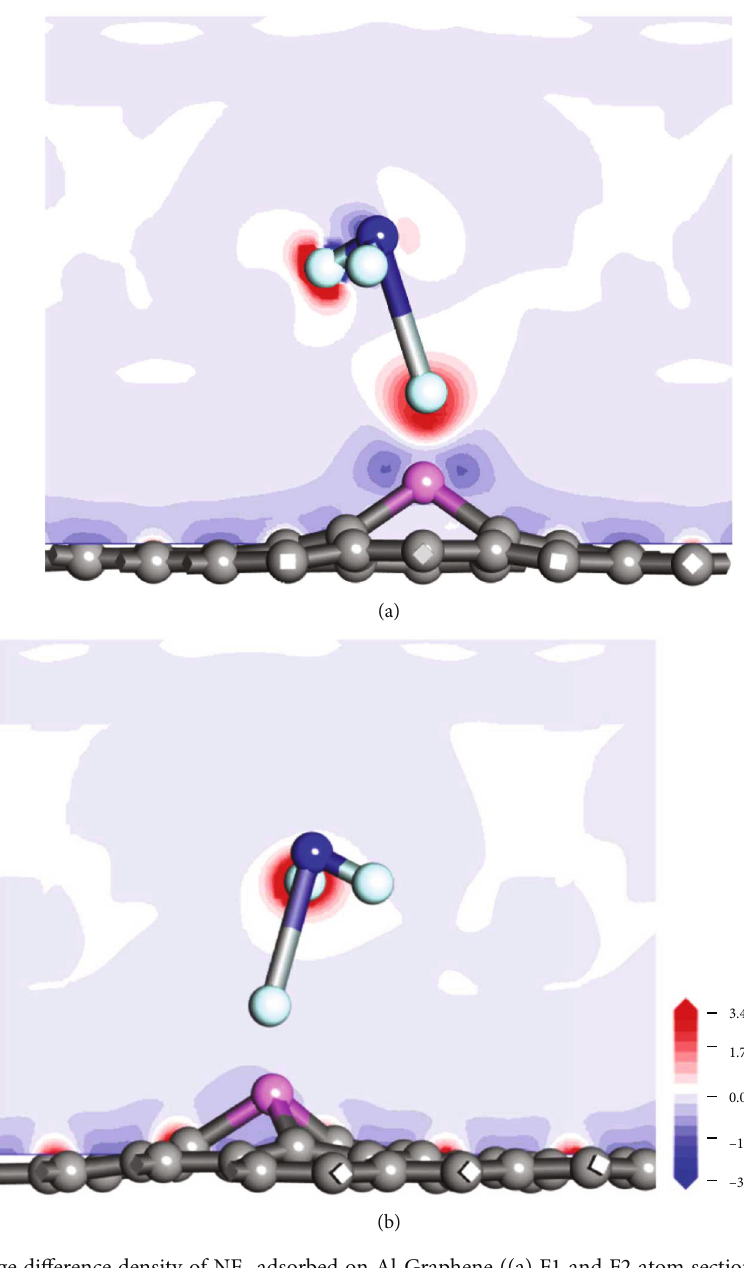
adsorbed on Al-Graphene ((a) F1 and F2 atom section; (b) F3 atom 3